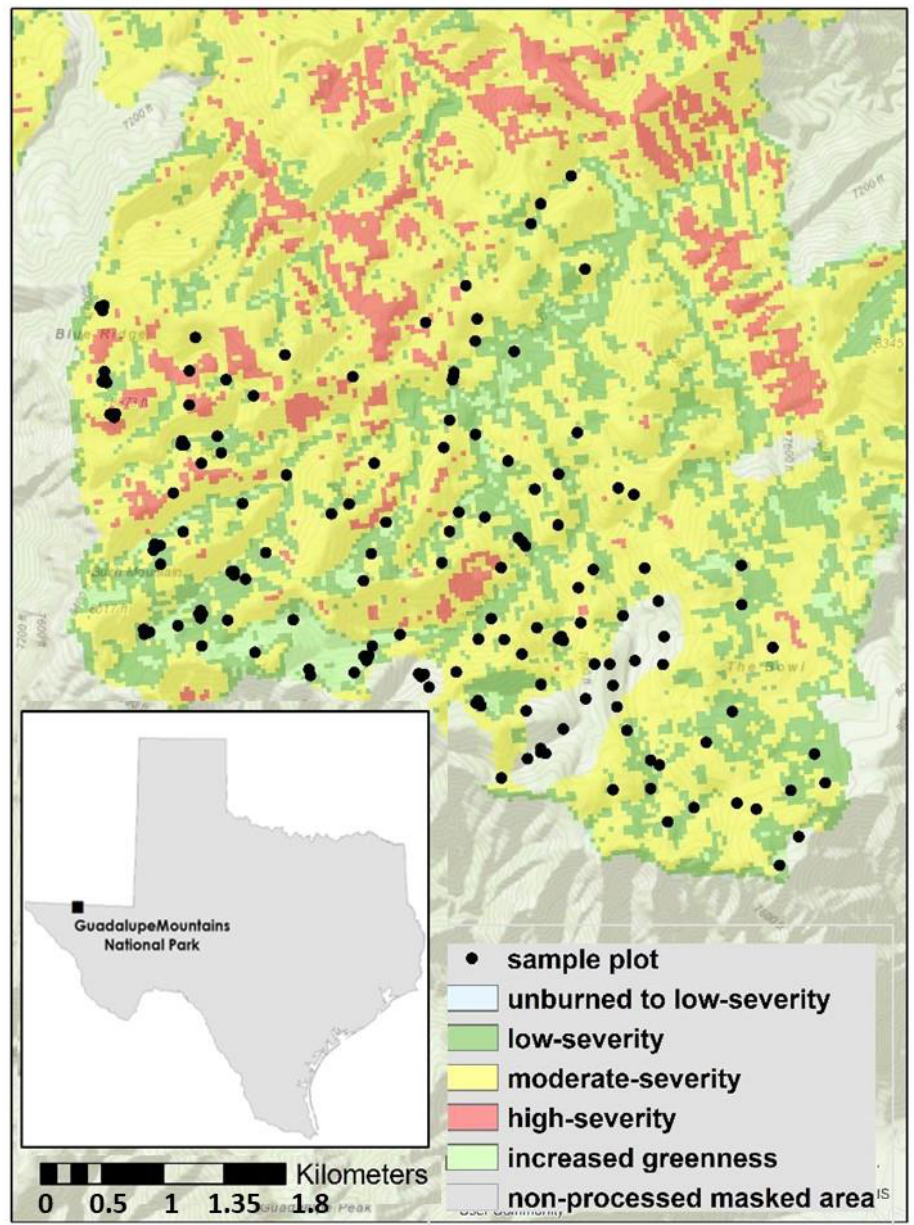
Figure 1. Map of the sample plot network that was sampled to quantify fire effects of the 2016 Coyote Fire in Guadalupe Mountains National Park, Texas. Sample plots are displayed on top of the MTBS (https://www.mtbs.gov/ (accessed on 25 March 2018)) fire severity map of the Coyote Fire.